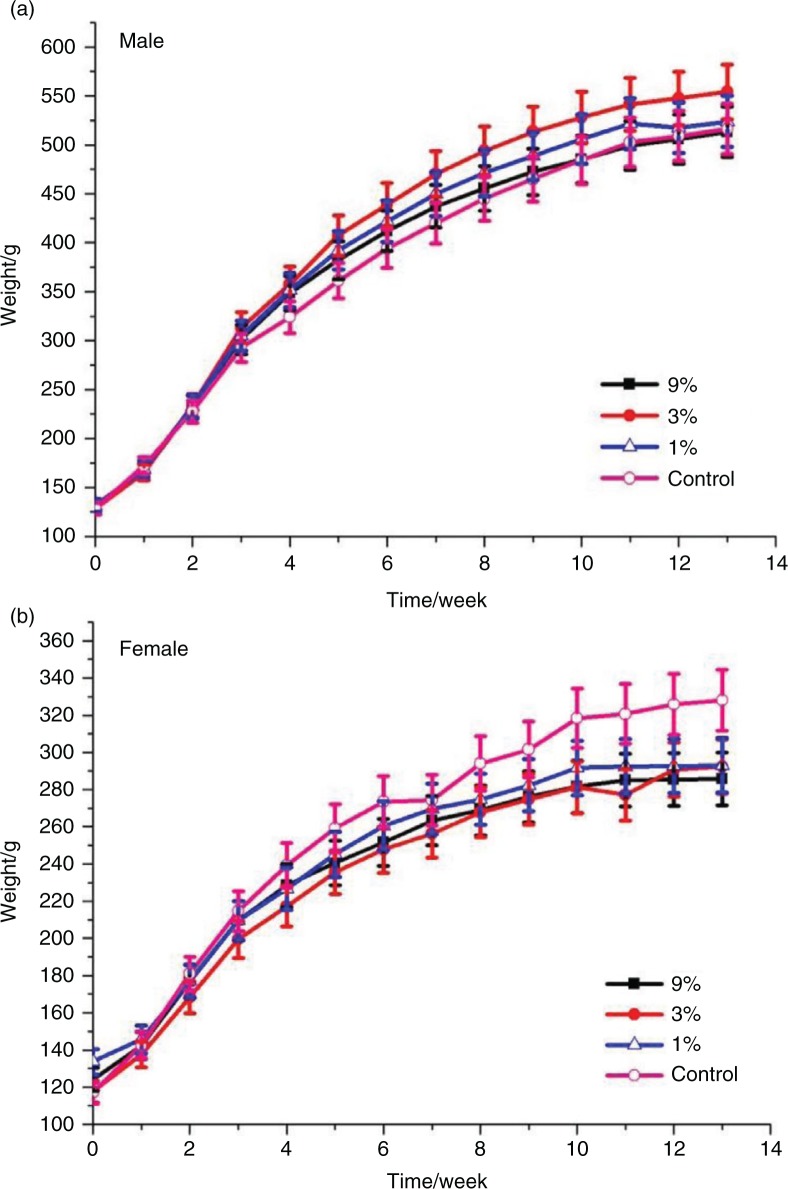
Growth curves for male and female Sprague-Dawley rats treated with MRPB for 13 weeks. (a) Cumulative bodyweight curves for males rats during 13-week study; (b) Cumulative bodyweight curves for female rats during 13-week study. MRPB, Maillard reaction products of chicken bone hydrolysate; 9, 3, and 1%, and control represents 9, 3, 1, and 0% of MRPB in diet for rats.